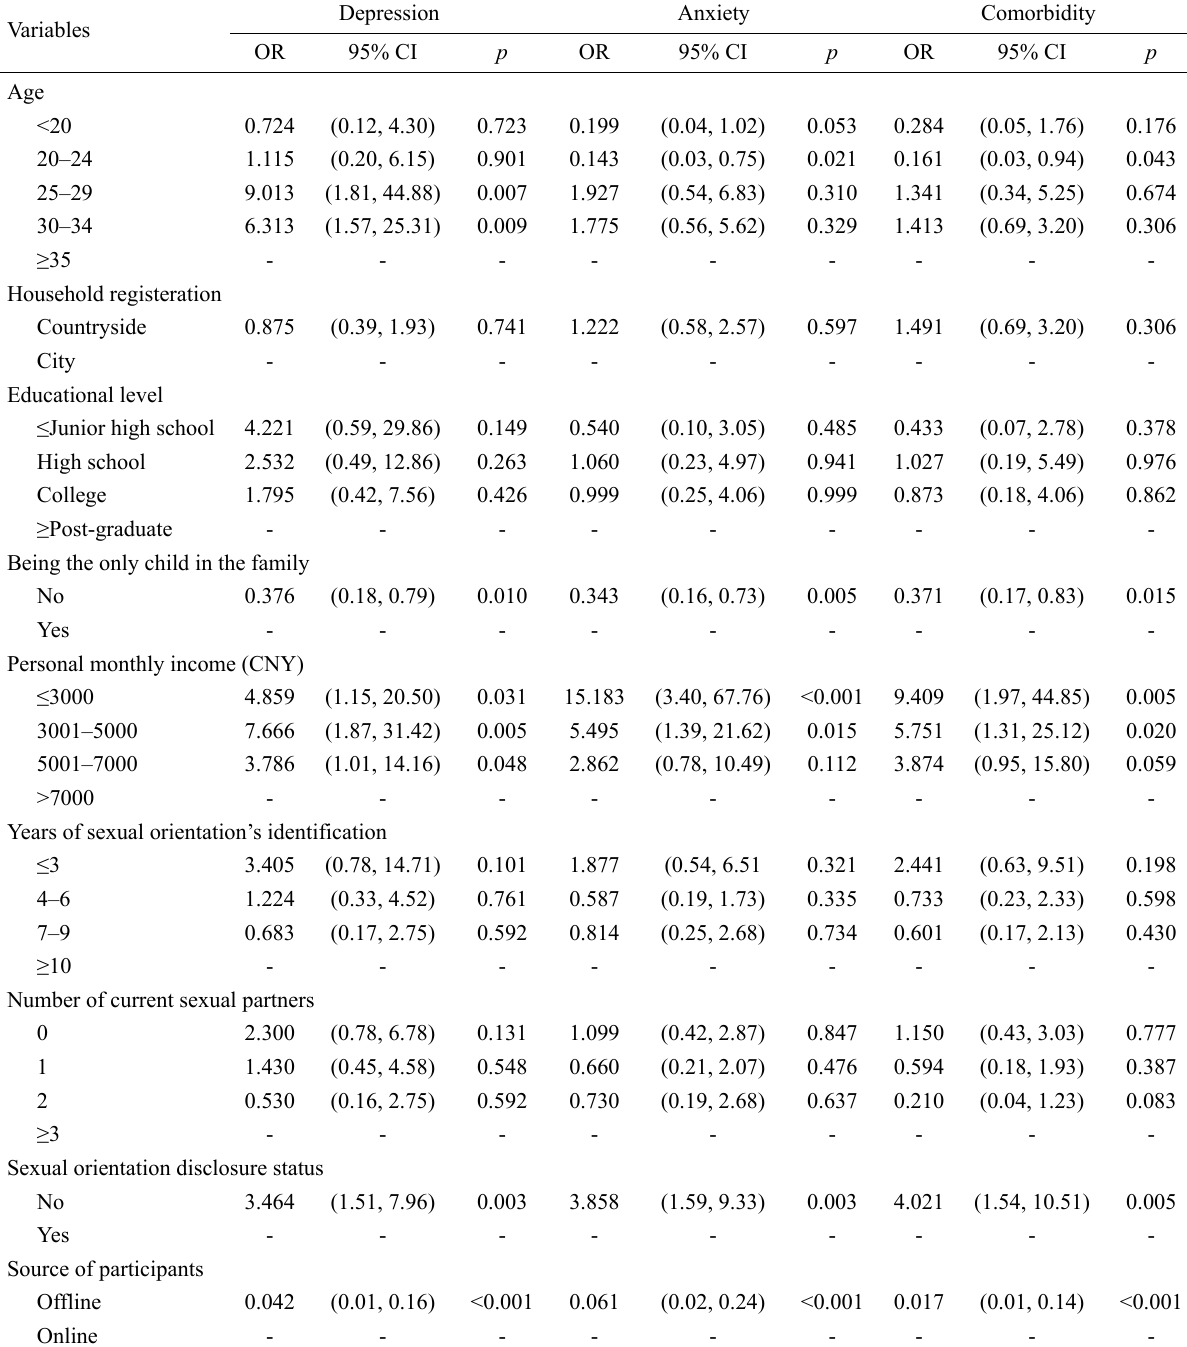
Table 3. Associations between demographic characteristics and depression, anxiety and the comorbidity of the two disorders.